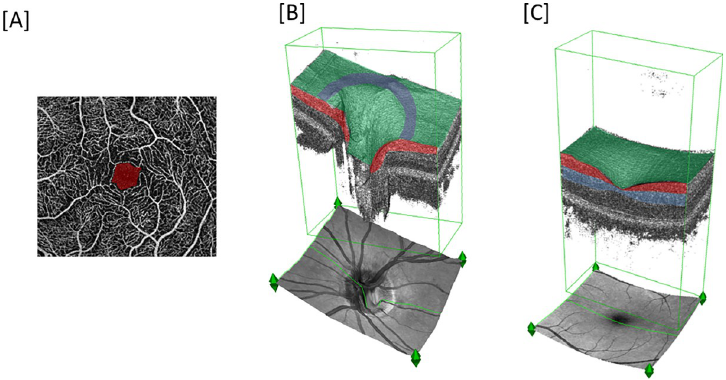
superimposed color coding representing segmentation layers and topical regions: radial peripapillary capillary (RPC) layer (red), whole-en-face region (green), peripapillary region (purple). (C) macular 3D-reconstruction image with superimposed color coding representing segmentation layers and topical regions: superficial capillary plexus (SCP) (red), deep capillary plexus (DCP) (blue), whole-en face region (green).